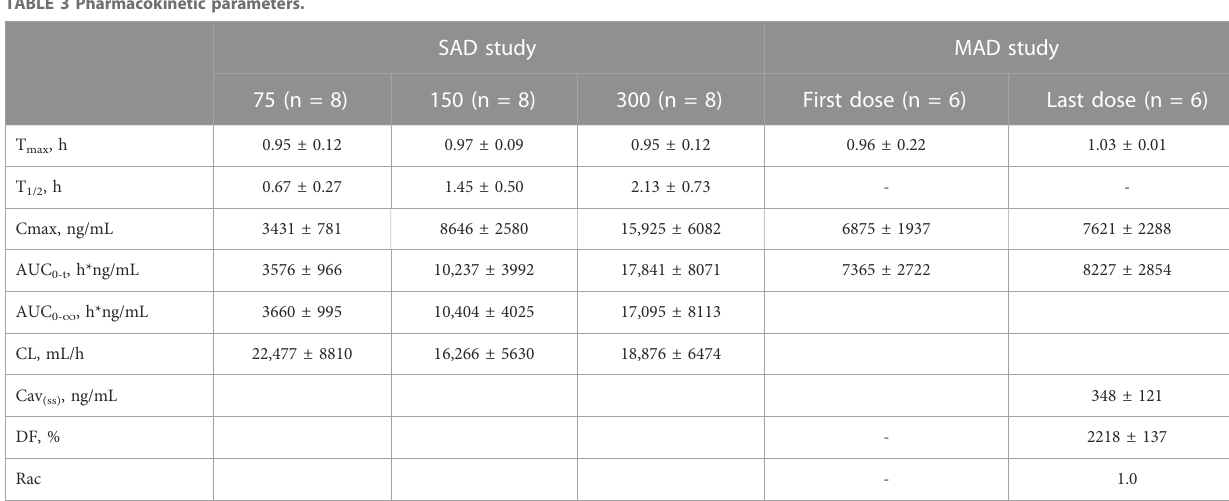
TABLE 3 Pharmacokinetic